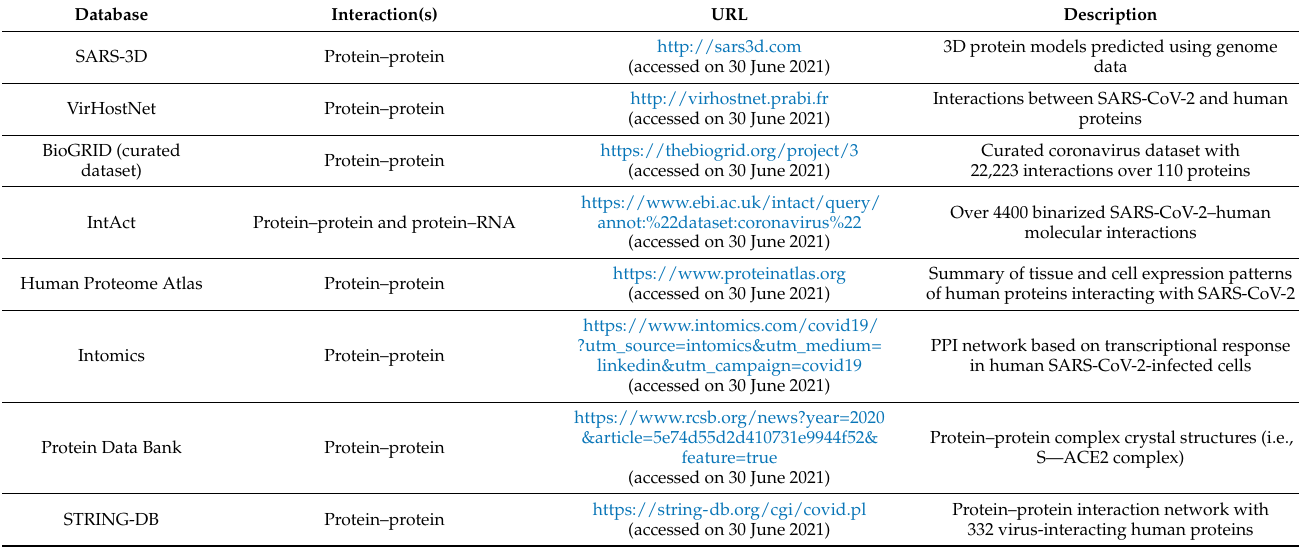
Table 2. Publicly available databases containing at least one of the SARS-CoV-2 HPI types. These databases were last accessed in June